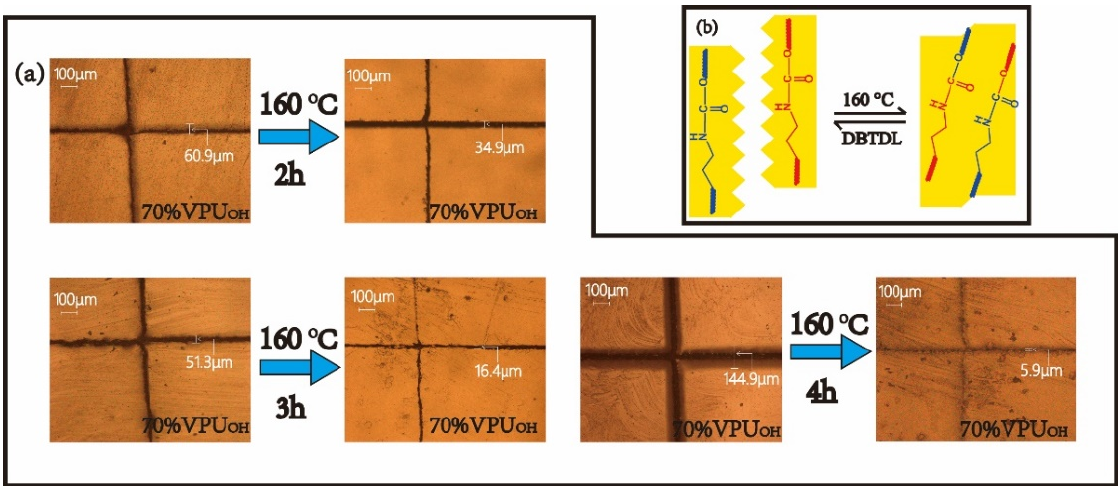
Figure 6. ( a ) Optical microscope images of the self-healing performance of 70%VPU OH , ( b ) Schematic representation of the transcarbamoylation exchange reaction.